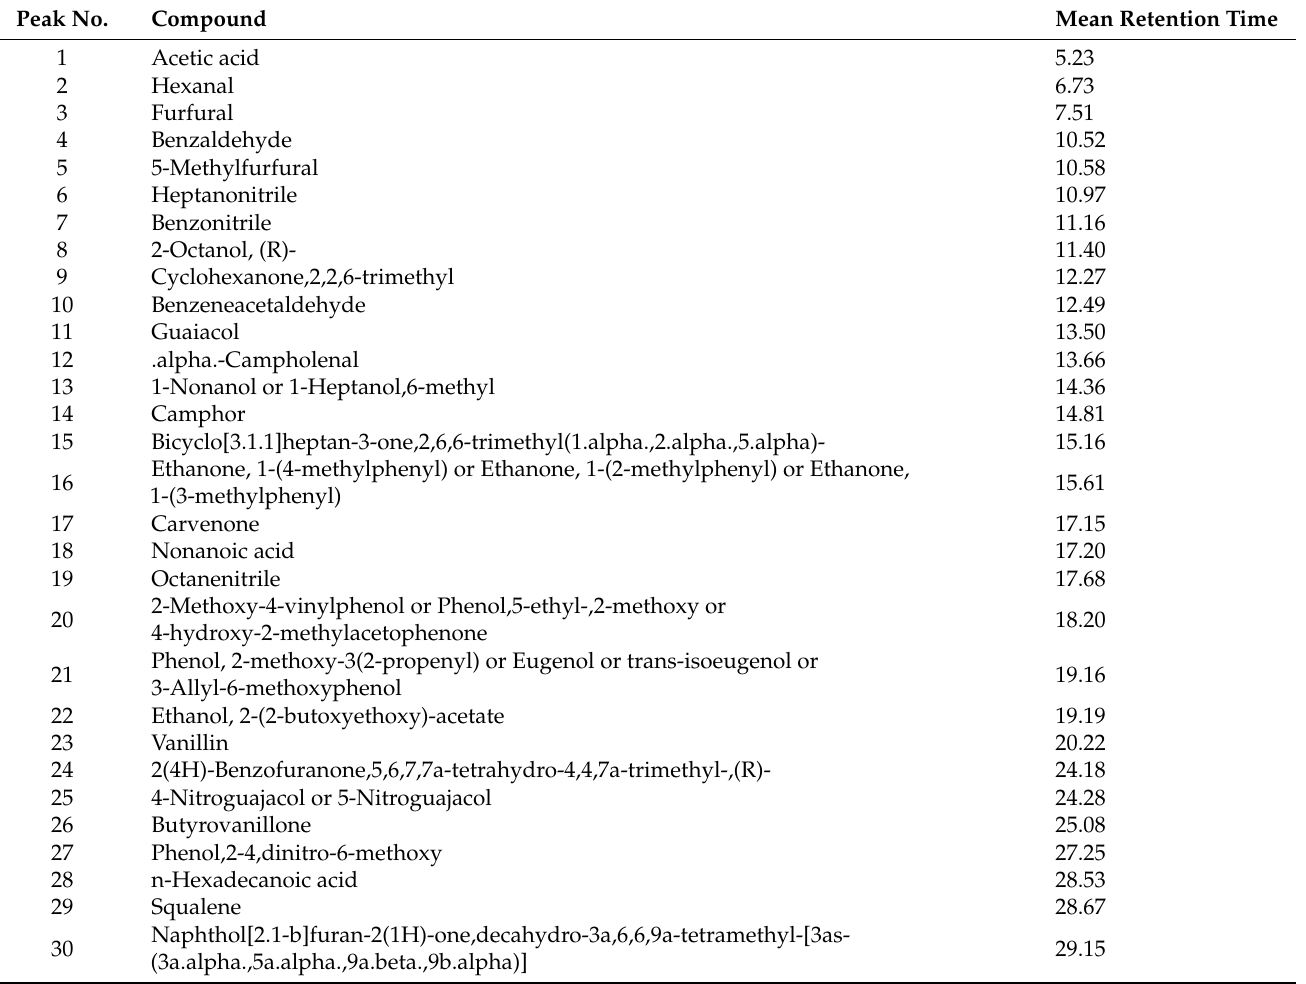
Table 6. Summary of selected compounds detected by GC-MS in the digestate (DG) and forest residue (FR) liquids that were generated by hydrothermal treatment. The peak numbers (Peak No.) are connected to Figures